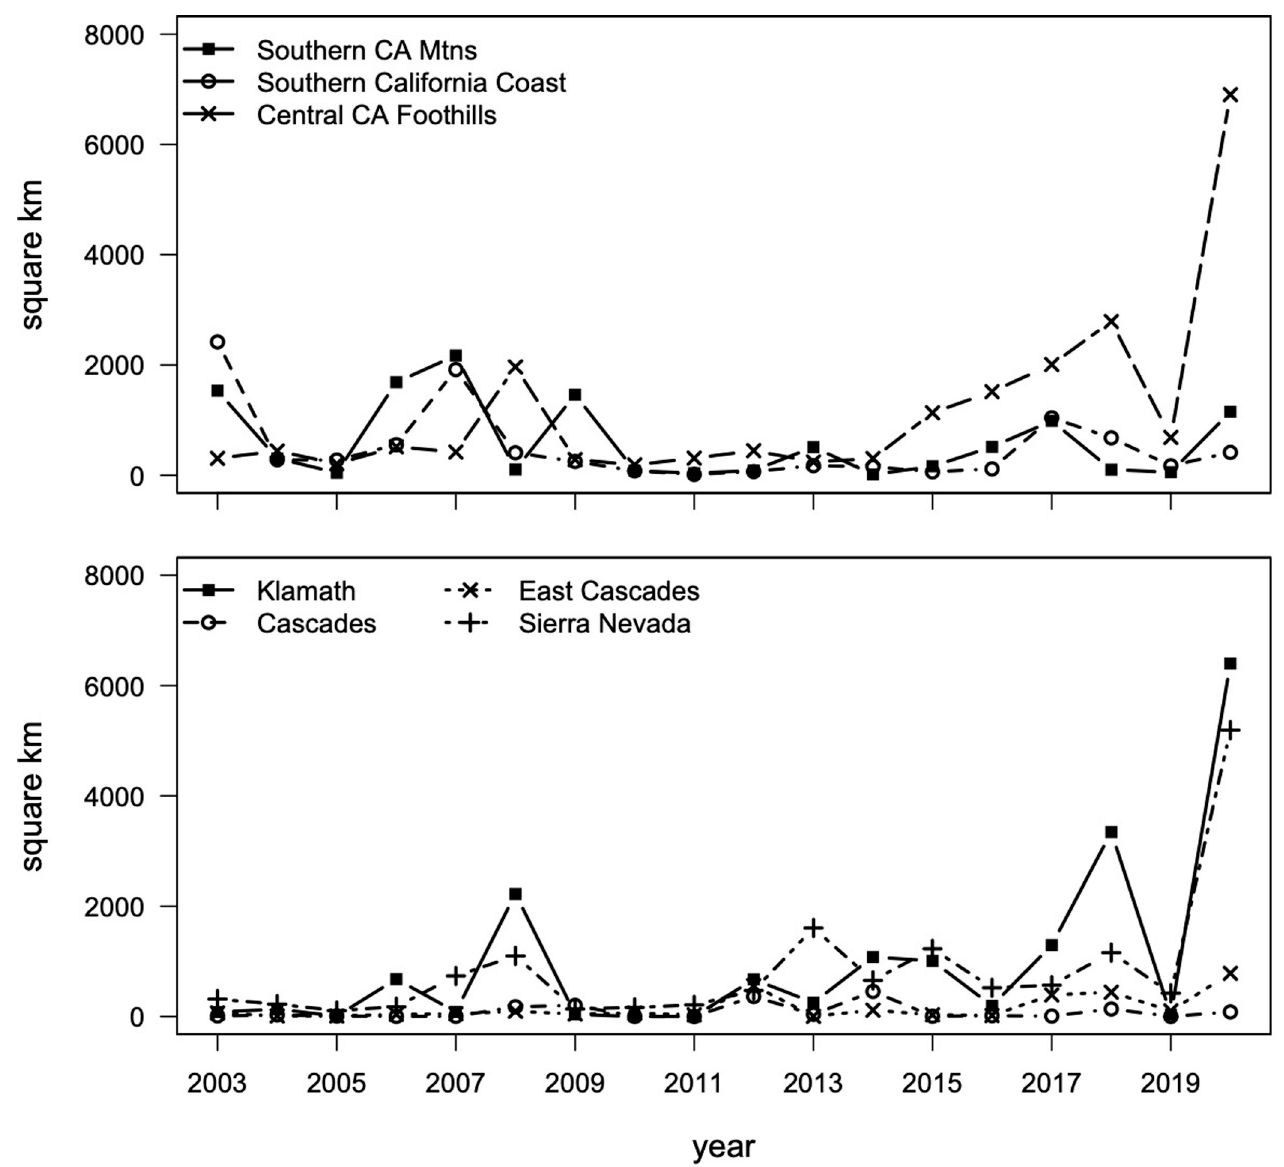
Fig 3. California ecoregion specific total annual burned area for 2003–2020 based on MODIS MCD64A1 approximate date-of-burn product. Ecoregions are split into roughly southern (top) and northern (bottom) California. Total burned area each year represented in square kilometers.